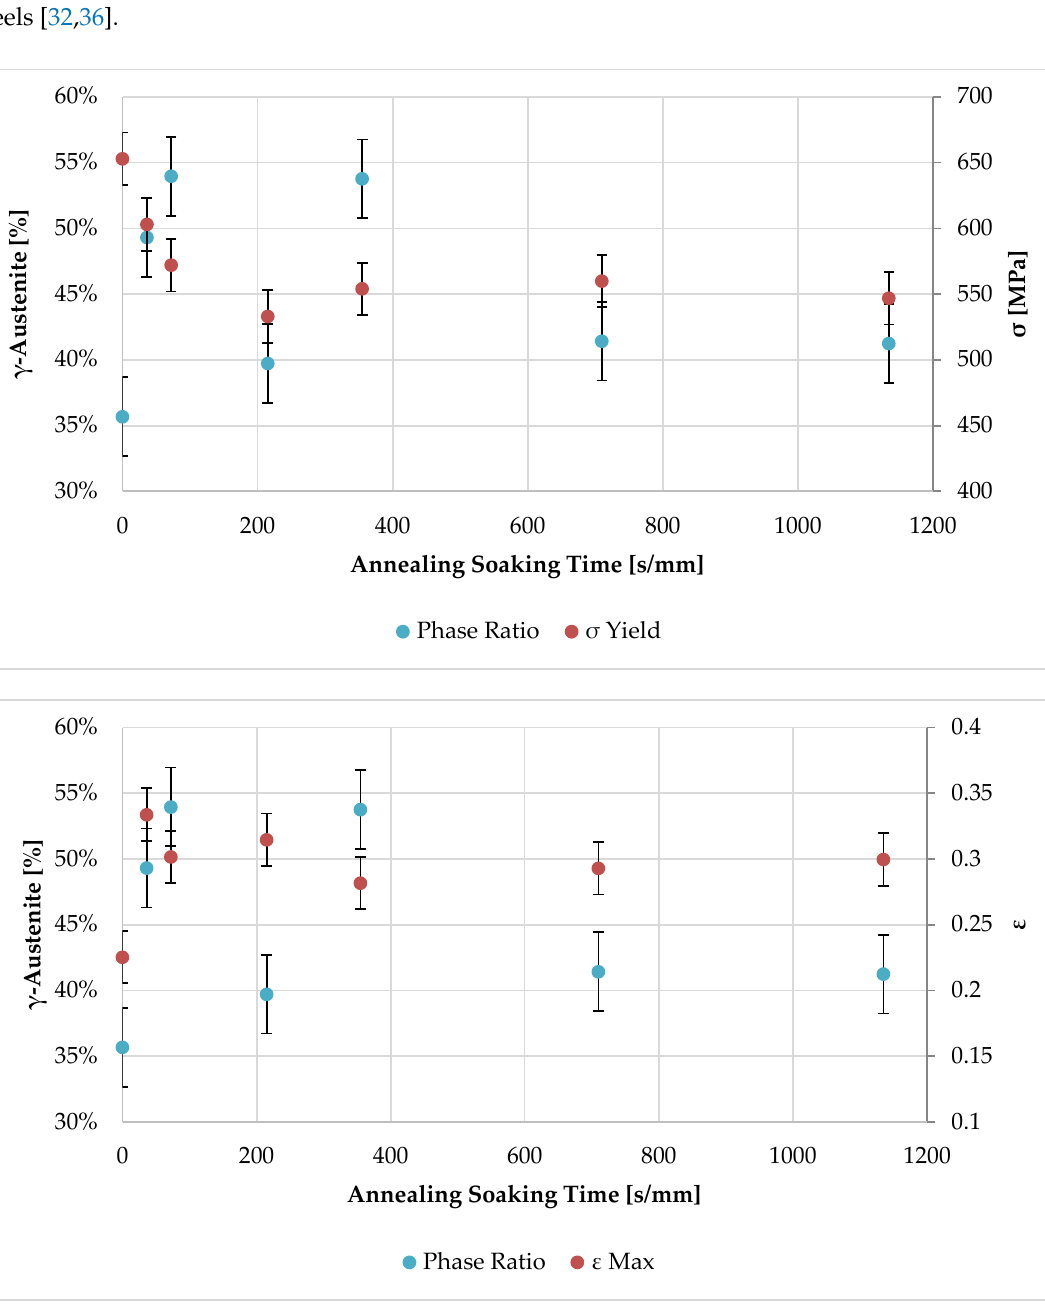
Figure 5. UNS S32760 tensile test results combined with the evolution of the phase ratio with the ongoing of the annealing thermal treatment. No specific trend appears; moreover, no correspondence can be underlined.